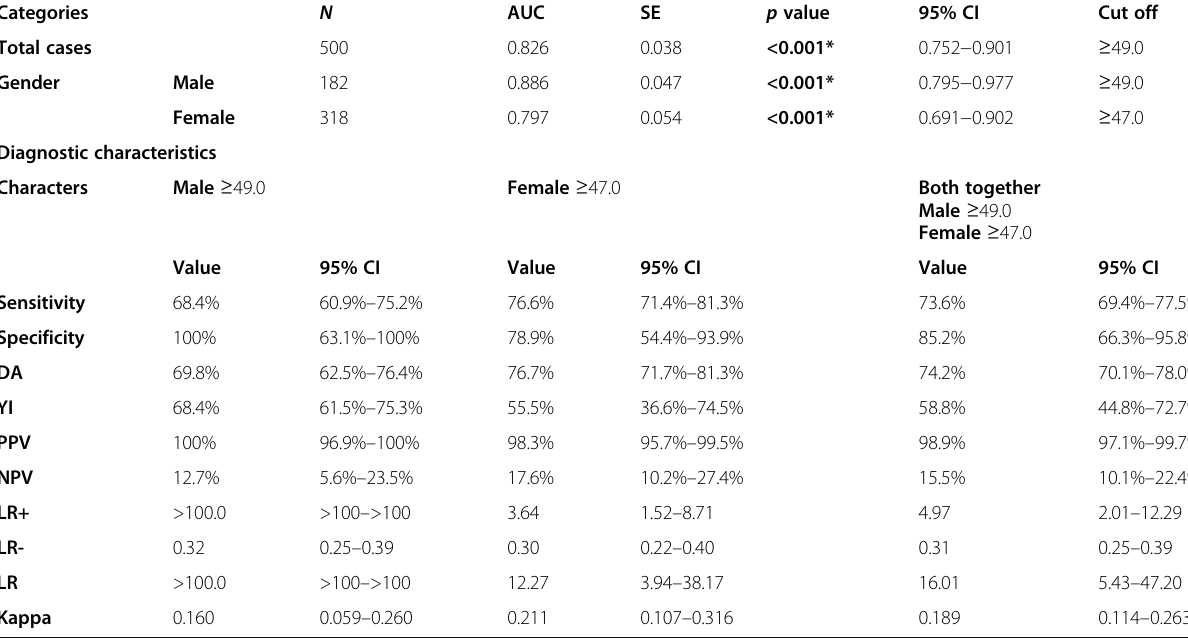
Table 4 Diagnostic performance and characteristics of COVID-19 Life Events — Anxiety Inventory